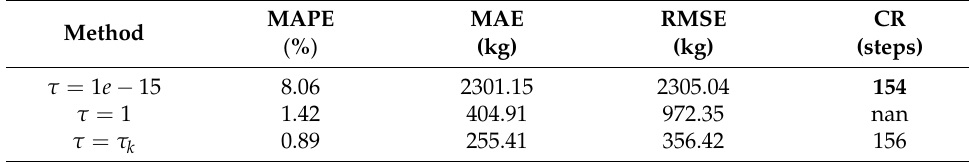
metrics of Different Weight Factors :::::: :